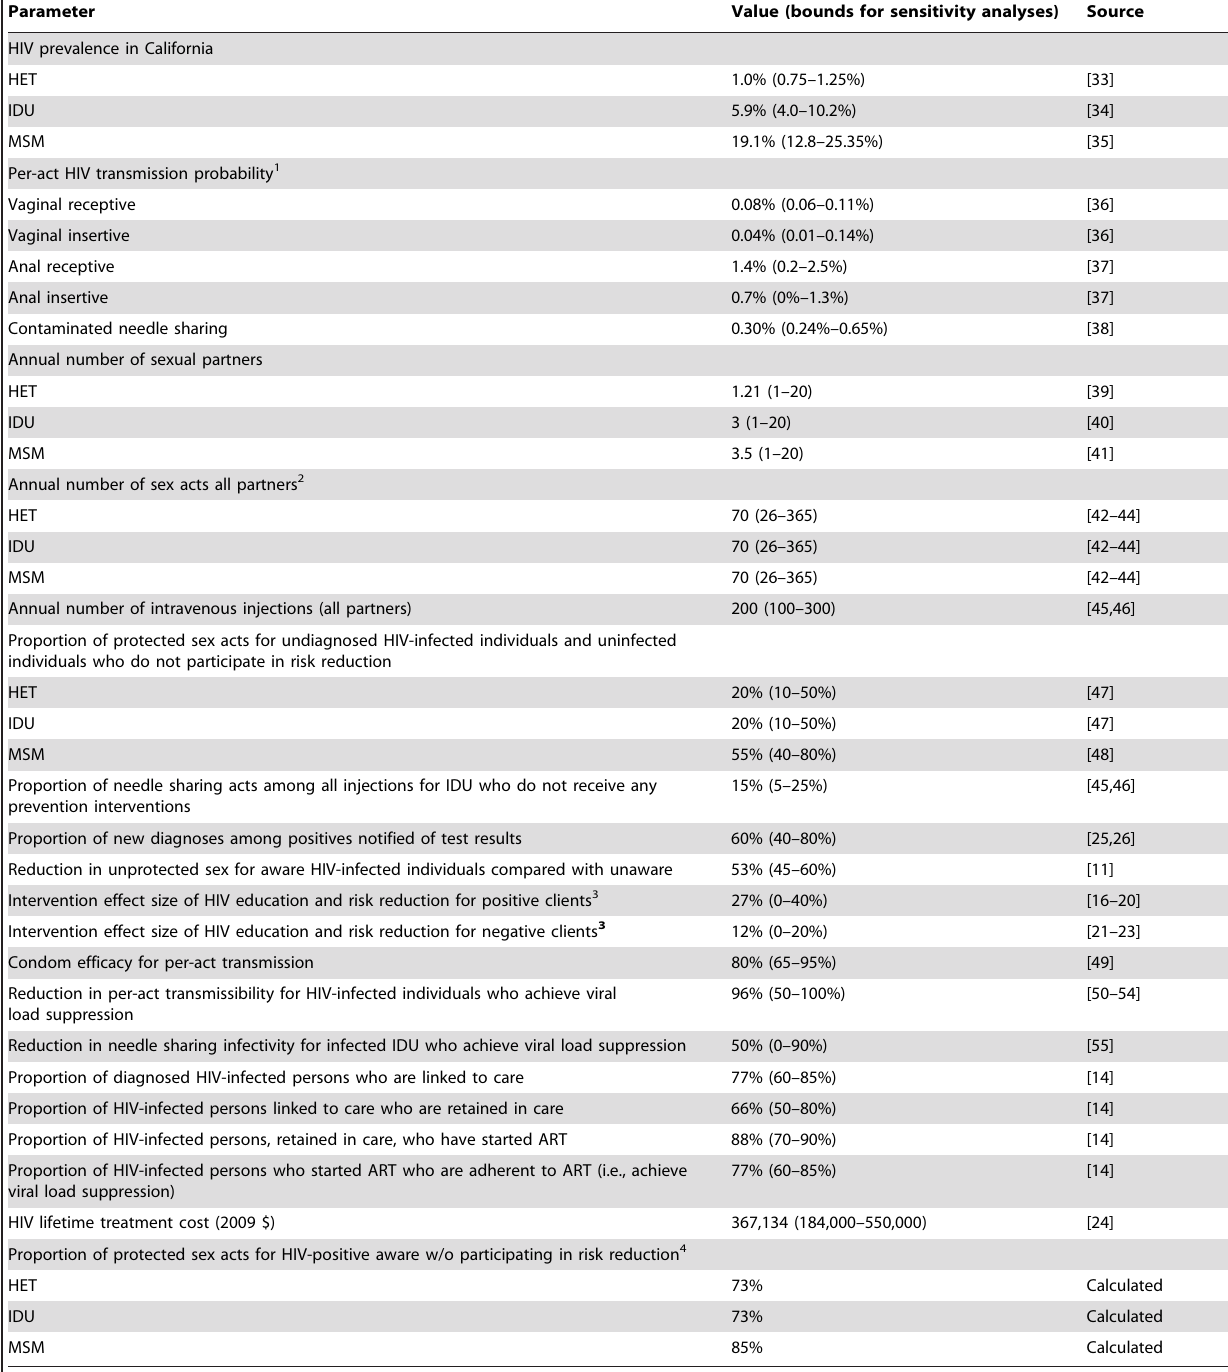
Table 1. Summary of key model